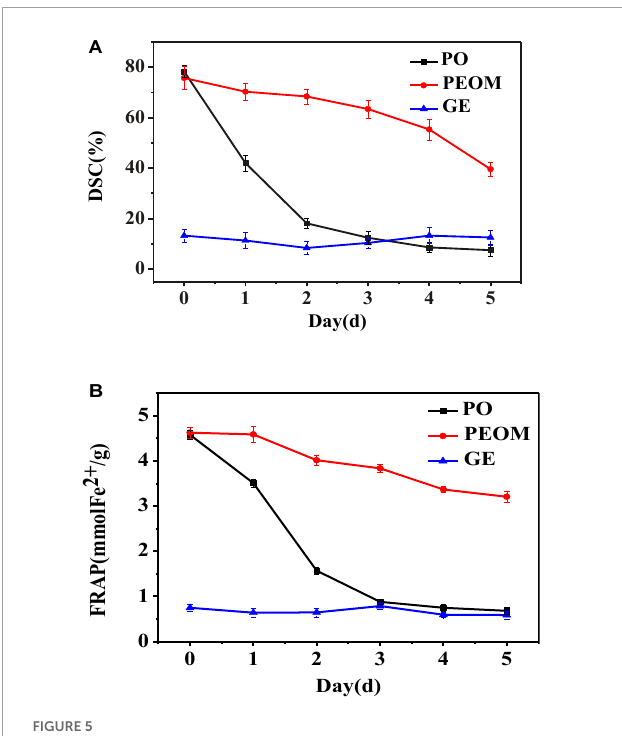
FIGURE4 Release curves of Perilla essential oil microcapsules (PEOM) at different temperatures.